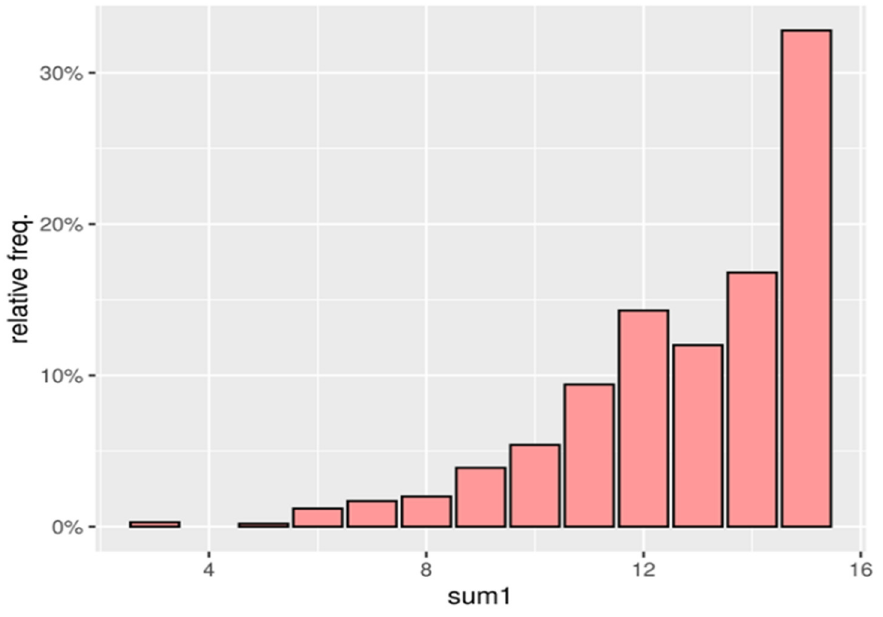
Figure 5. Frequency of repetitions to answers contained in sum1.